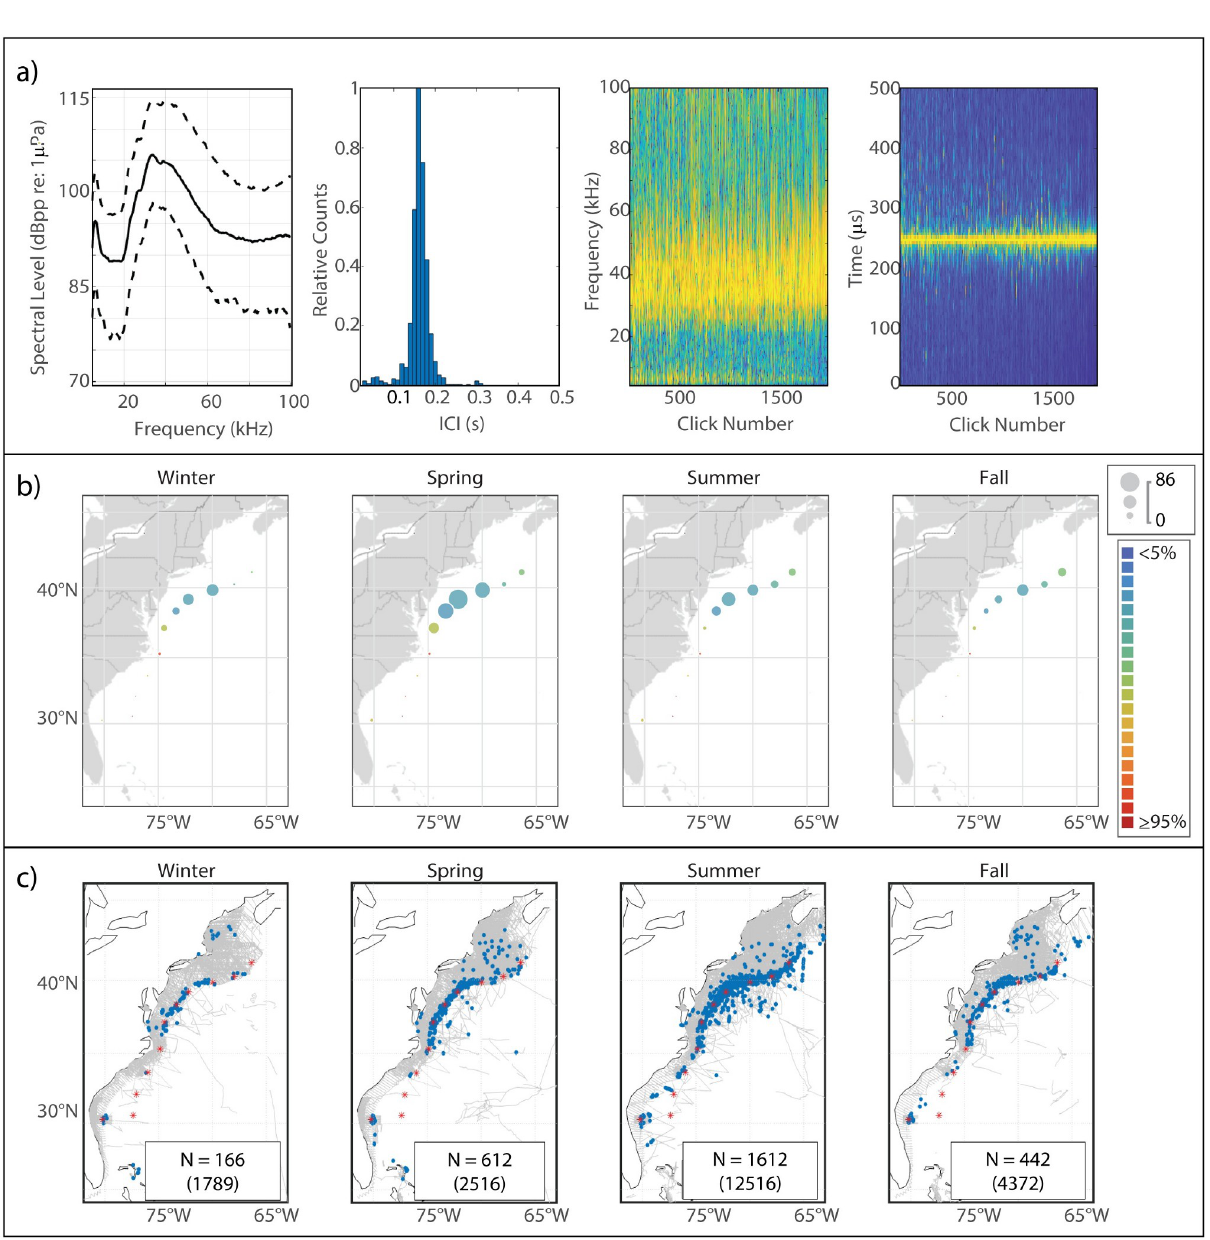
Fig 10. Results for UD36 showing click type (a), acoustic presence (b), and historical sightings of probable species match, Risso’s dolphin (c). Subplots as in Fig